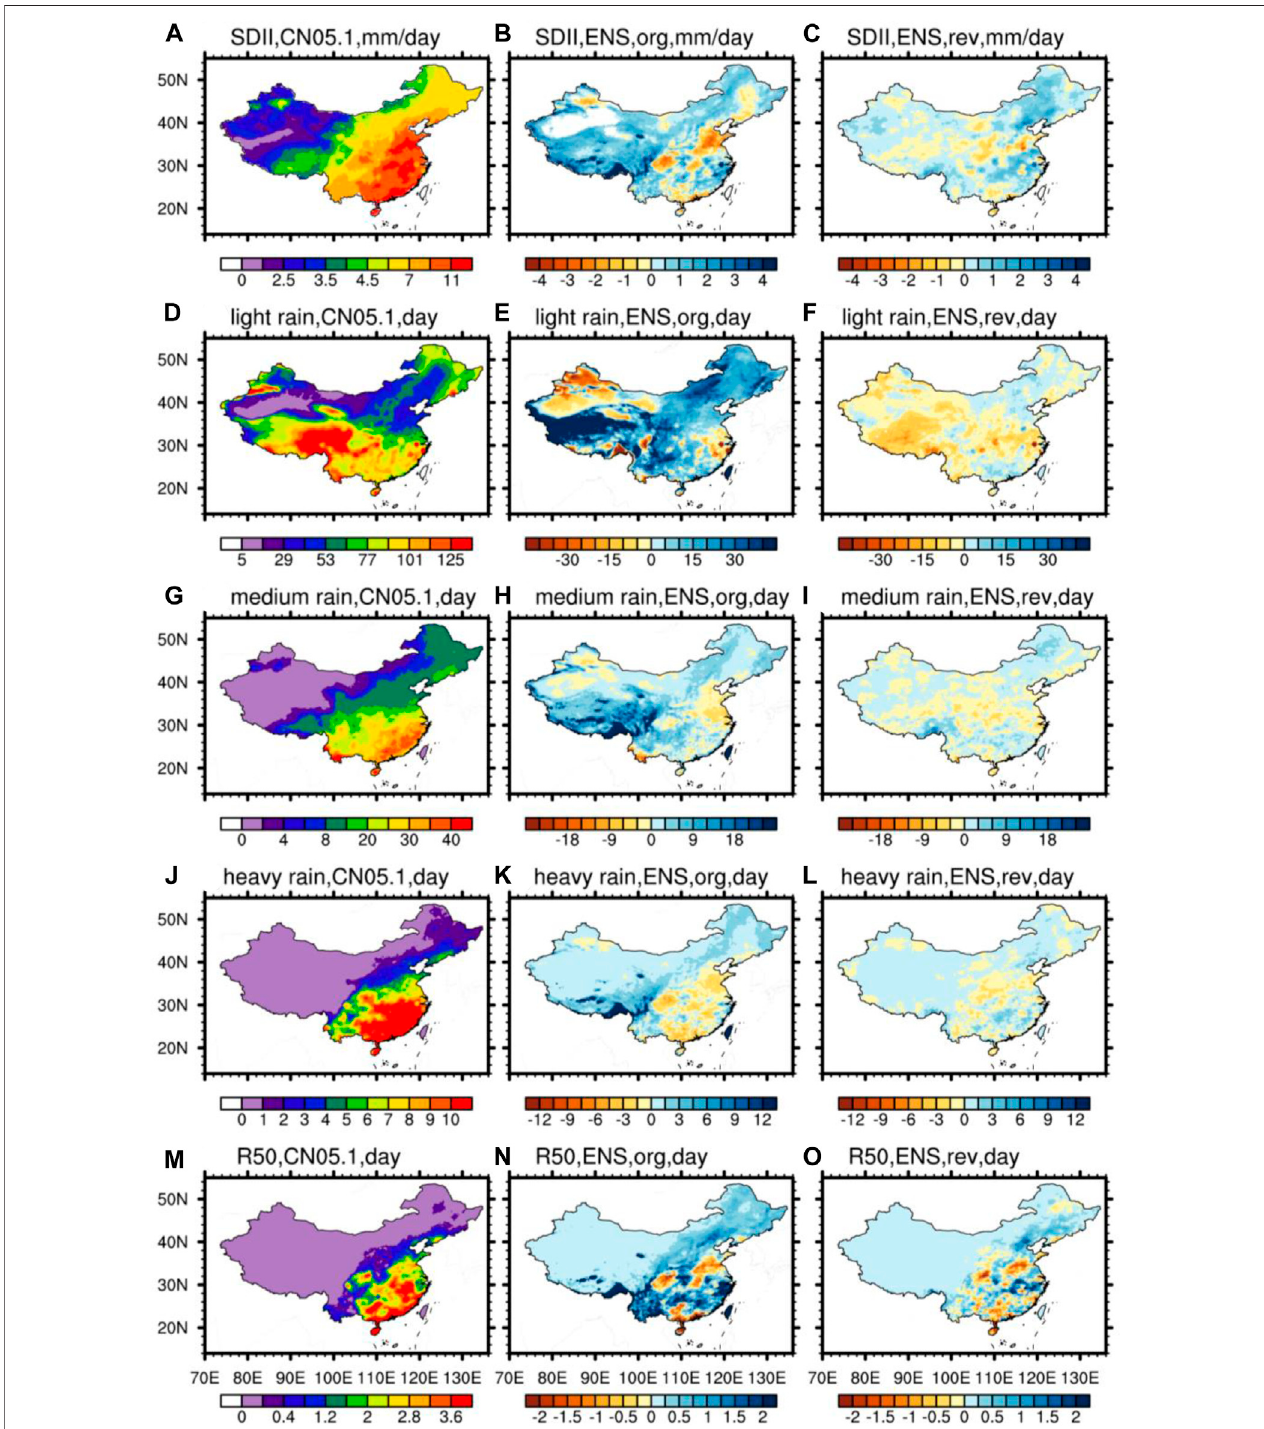
FIGURE 4 | The spatial distributions of observed extreme precipitation indexes (A,D,G,J,M) . The spatial distributions of the biases of the extreme precipitation indexes between observations and simulations before (B,E,H,K,N) and after correction (C,F,I,L,O) . The extreme precipitation indexes include the SDII (A – C) , the light rain (D – F) , the medium rain (G – I) , the heavy rain (J – L) , and the R50 (M – O) .